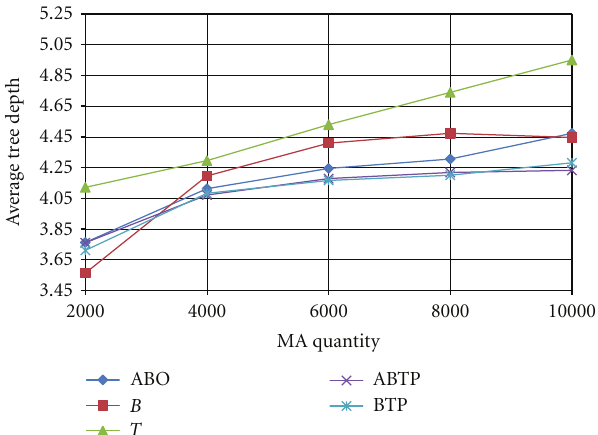
Figure 11: Average tree depth on di ff erent MA quantity and optimization criteria.